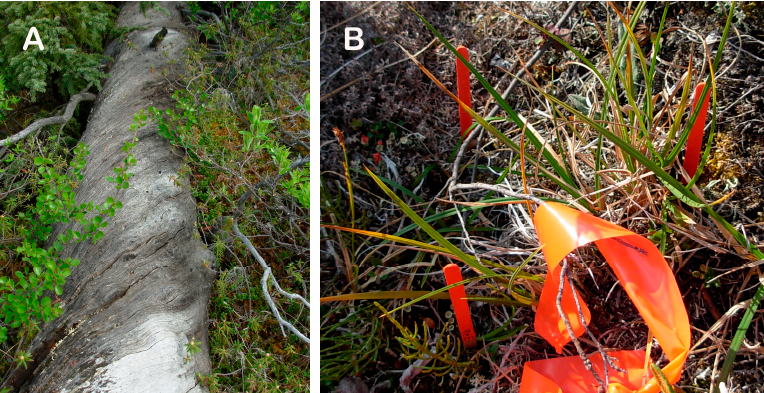
Figure 8. ( A ) A fallen snag that has lain on the tundra surface for >30 years. Severely spiral-grained specimens are common on site, but so too are perfectly straight-grained trees. ( B ) An example of poplar sticks used to investigate biomass turnover from July 2008 to September 2009.